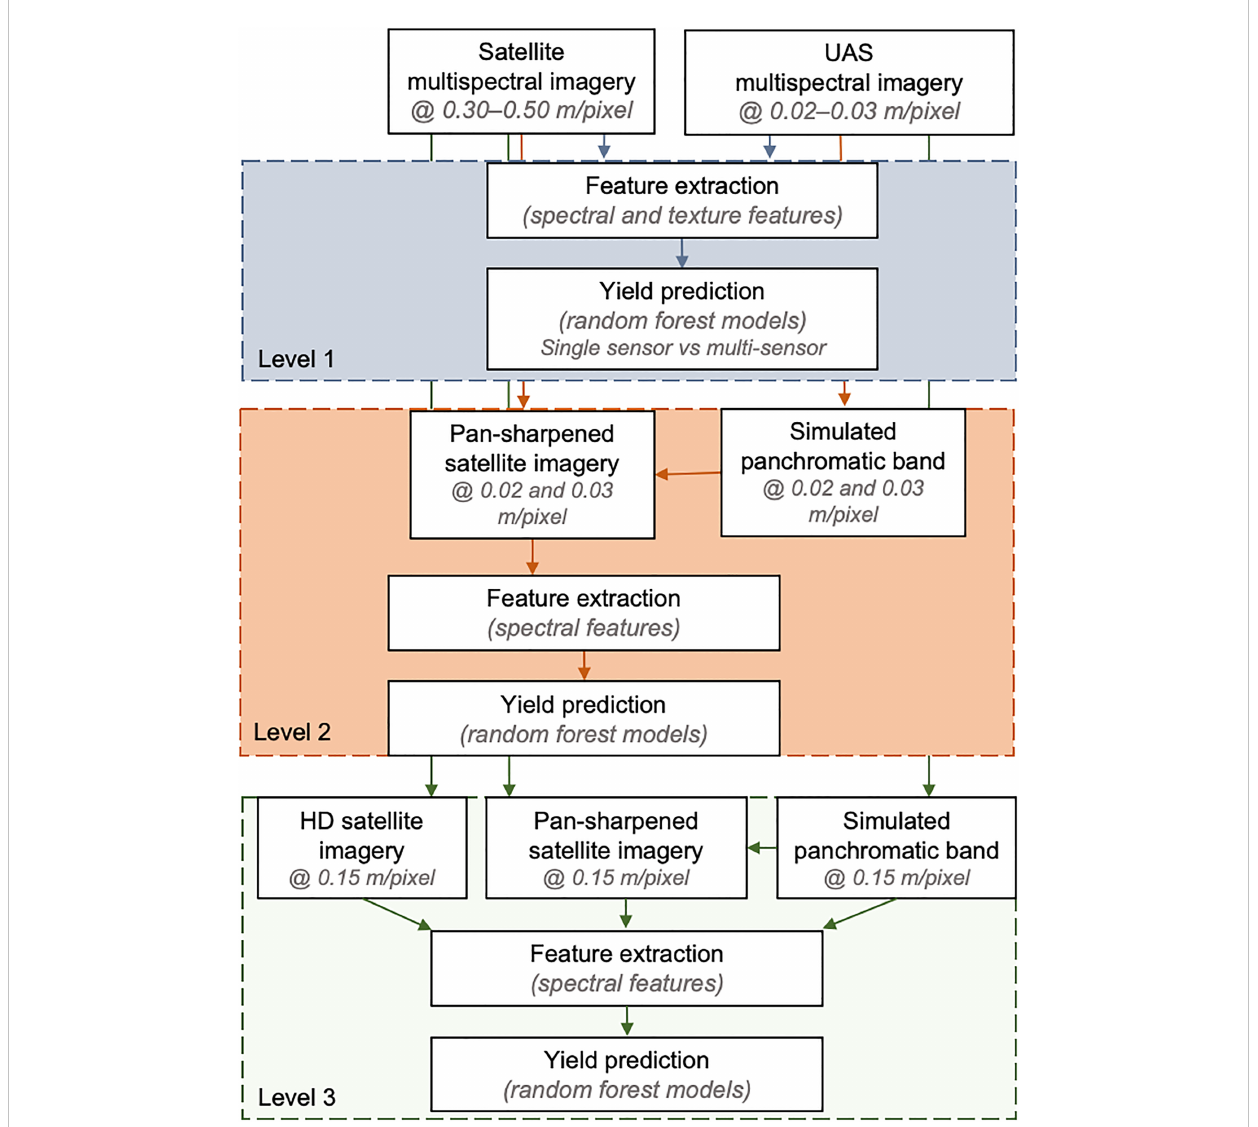
FIGURE 3 Image processing work fl ow for analyzing data extracted from satellite and UAS imagery. The top, middle and lower boxes refer to the evaluations in Level 1, Level 2, and Level 3, respectively. Level 1, 2, and 3 included feature extraction and yield prediction using extracted features from original resolution of the satellite and UAS imagery, pan-sharpening of satellite imagery using UAS imagery and feature extraction from the pan-sharpened imagery for yield prediction, and comparison of yield prediction using pan-sharpened image-based features and HD image features,